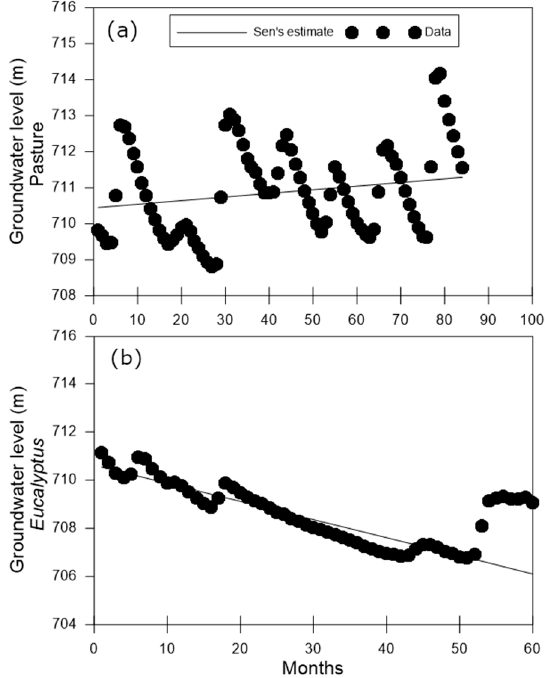
Figure 4. Monthly trend analysis of mean groundwater levels measured in the monitoring wells to ( a ) pasture and ( b ) Eucalyptus periods.